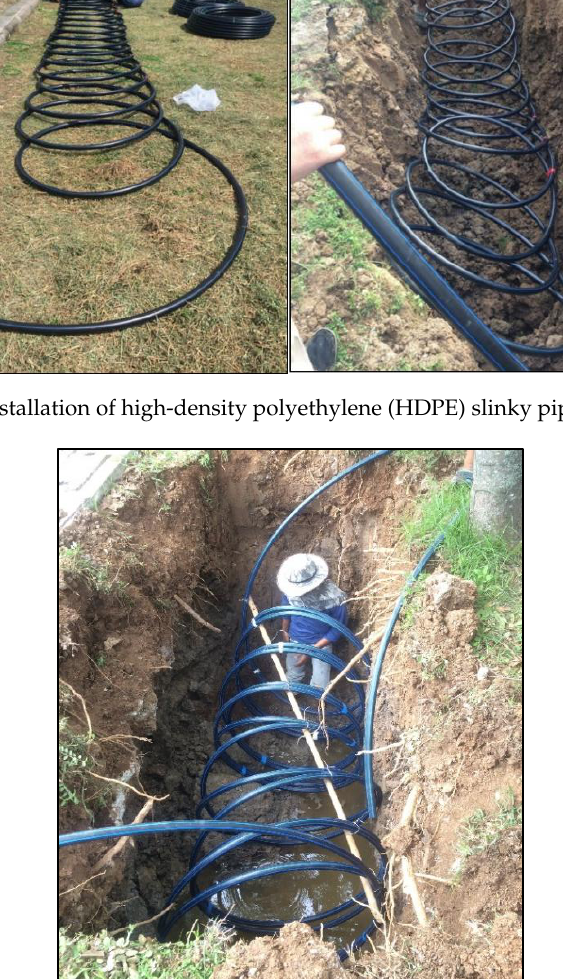
Figure 6. Installation of a helically configured heat exchanger (Group 4).